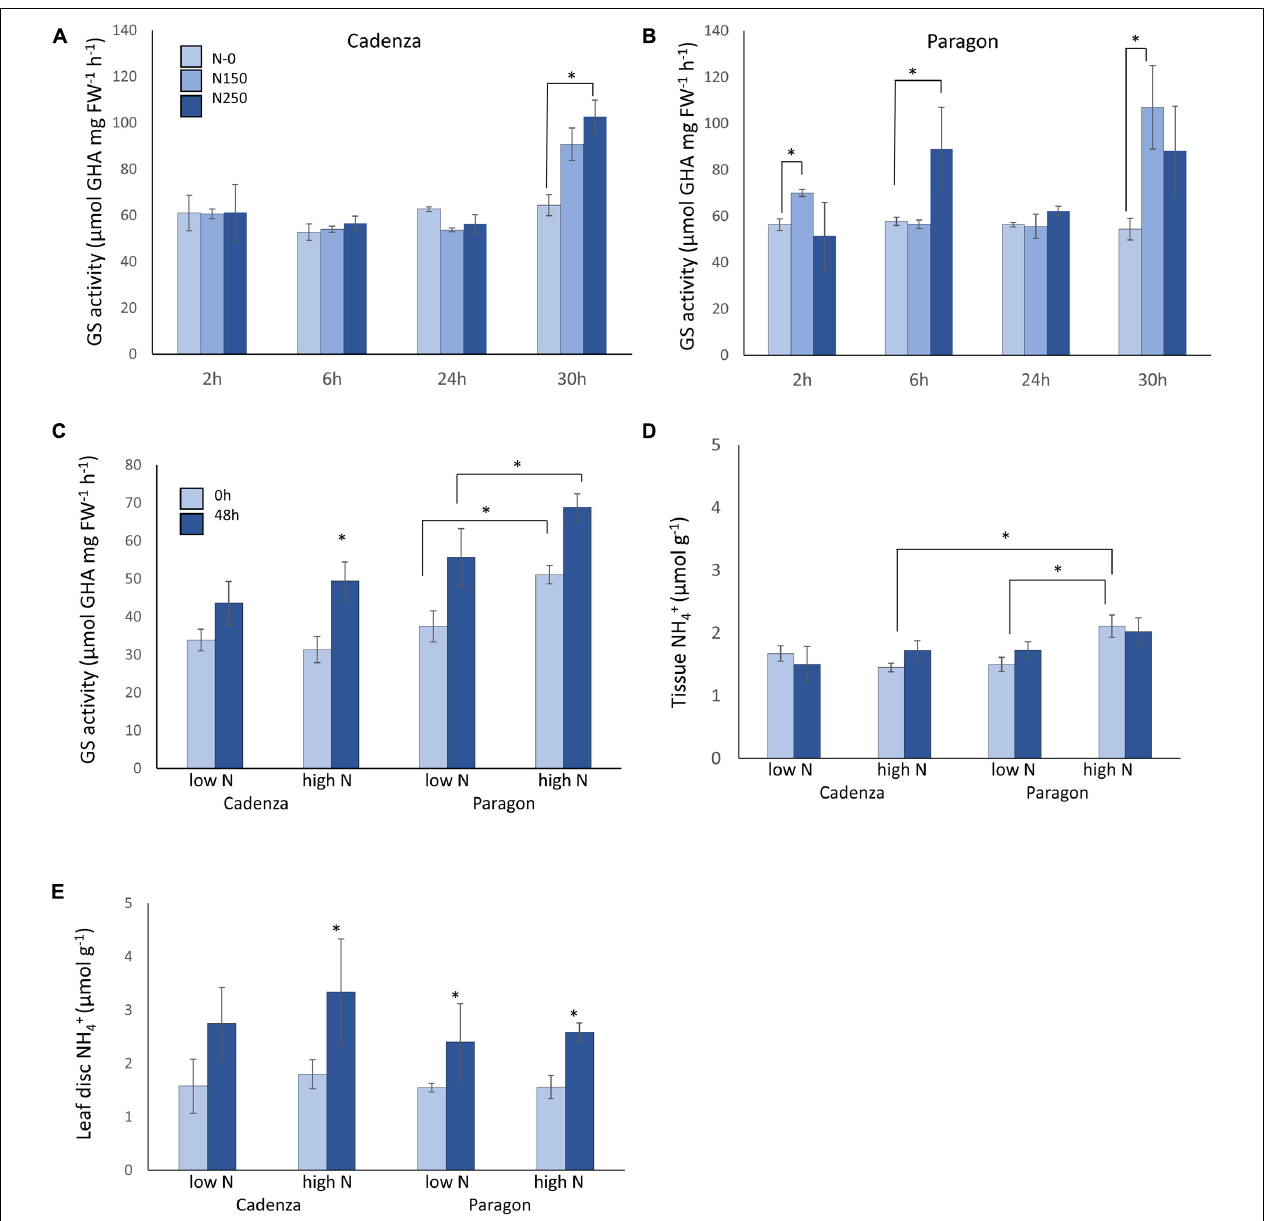
FIGURE 1 | Temporal response of wheat glutamine synthetase to N fertiliser under controlled and field conditions. The response of glutamine synthetase (GS) enzyme activity was measured in two bread wheat genotypes grown in fully fertilised (Osmocote slow-release fertiliser) potting mix. GS activity in leaf samples of Cadenza (A) and Paragon (B) was measured at four timepoints after application of NH 4 NO 3 , equivalent to 150 kg N ha − 1 (N150) and 250 kg ha − 1 (N250), respectively. Water was applied to control plants (N-0) and measured in parallel. Each value represents the mean ± SE of four biological replicates. The same genotypes were sampled from a long-term field experiment with plots adjusted to low (100 kg N ha − 1 ) and high (350 kg N ha − 1 ) total seasonal N application (see text for details). GS activity (C) , tissue ammonium (D) and leaf-disc assay ammonium (E) were measured in leaf samples collected before (0 h) and at 48 h after